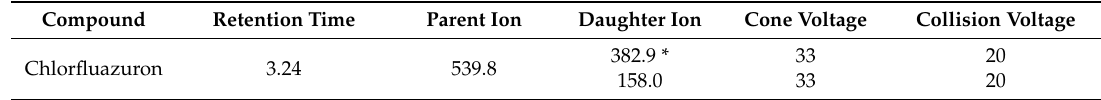
Table 2. Mass spectrometry conditions for chlorfluazuron analysis.